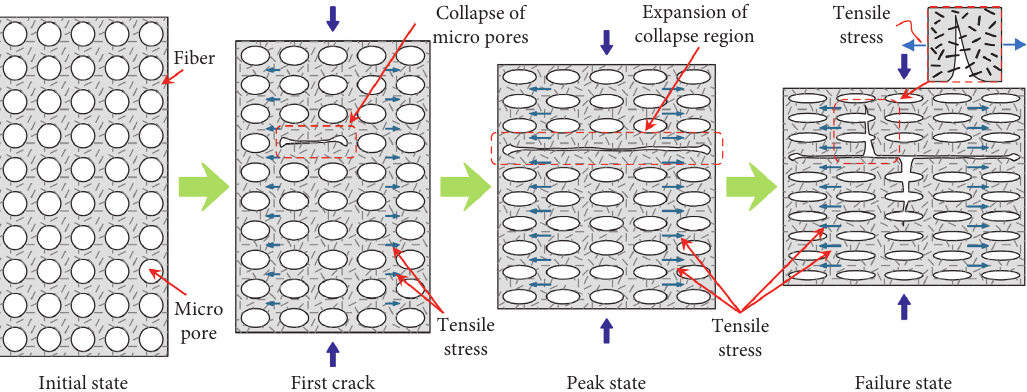
Figure 8: Damage evolution mechanism of specimens with compaction failure.